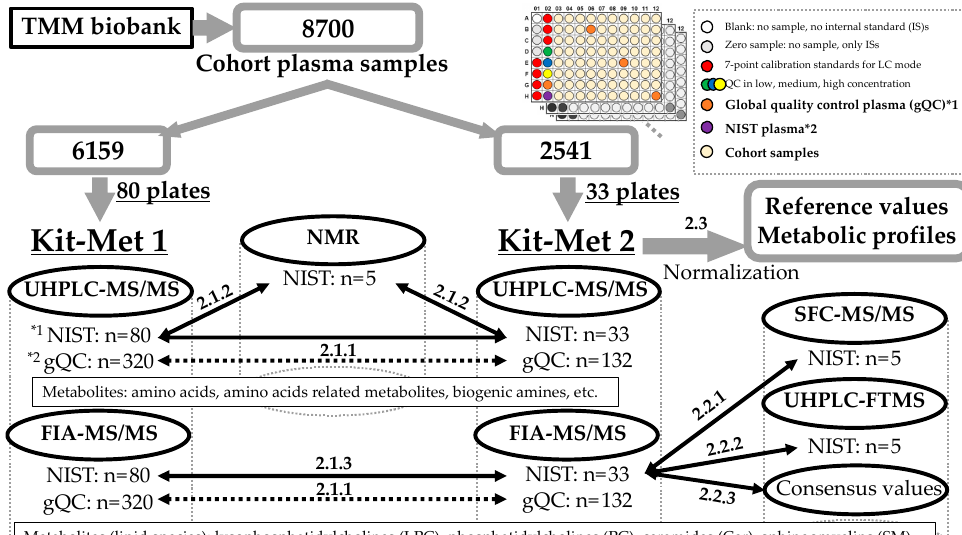
Figure 1. Summary of the present study. Kit-Met 1 and Kit-Met 2 were performed by the Xevo ® TQ-S and Xevo ® TQ-XS MS system (Waters, Wilmslow, Manchester, UK), respectively. Both MS systems were conducted with the UHPLC system, which consisted of dual pumps (ACQUITY UPLC H-Class, Waters) and an autosampler with a column compartment (ACQUITY UPLC I-Class, Waters).